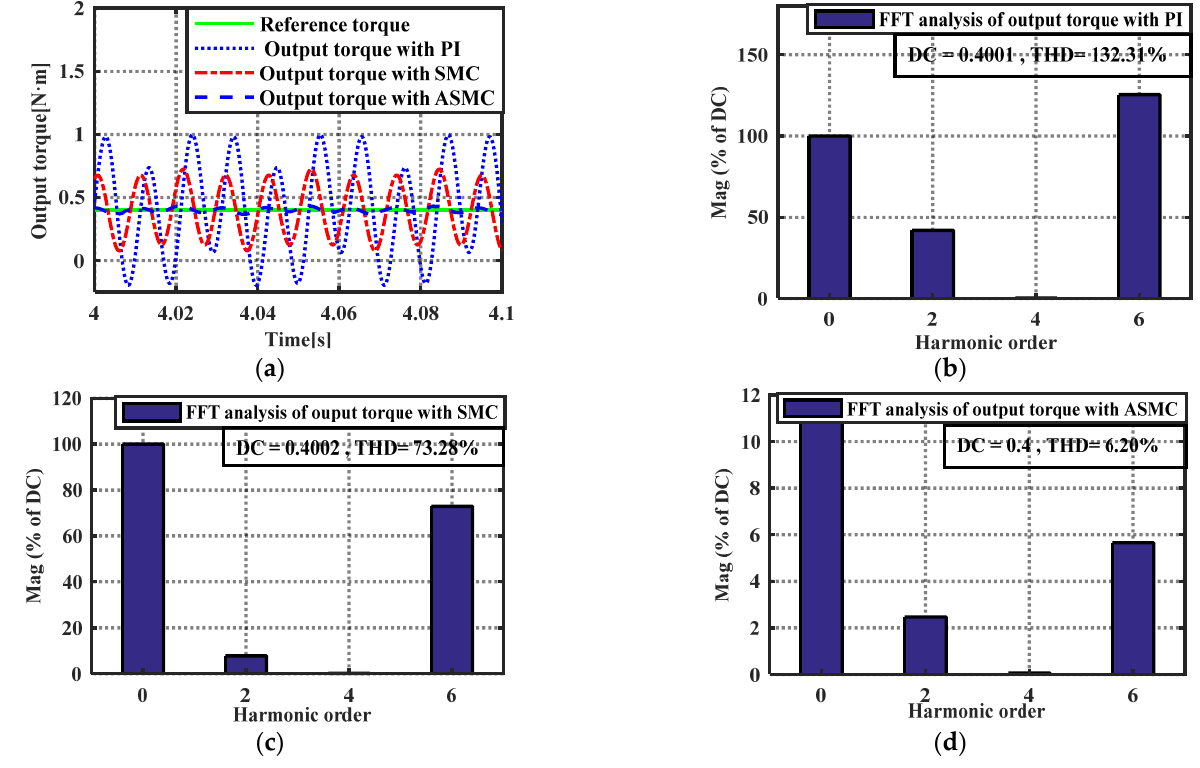
Figure 8. Output torque curves with three control methods and their FFT analysis. ( a ) Output torque curves using three control methods; ( b ) FFT analysis of the output torque by using PI controller; ( c ) FFT analysis of the output torque by using SMC; ( d ) FFT analysis of the output torque by using ASMC.